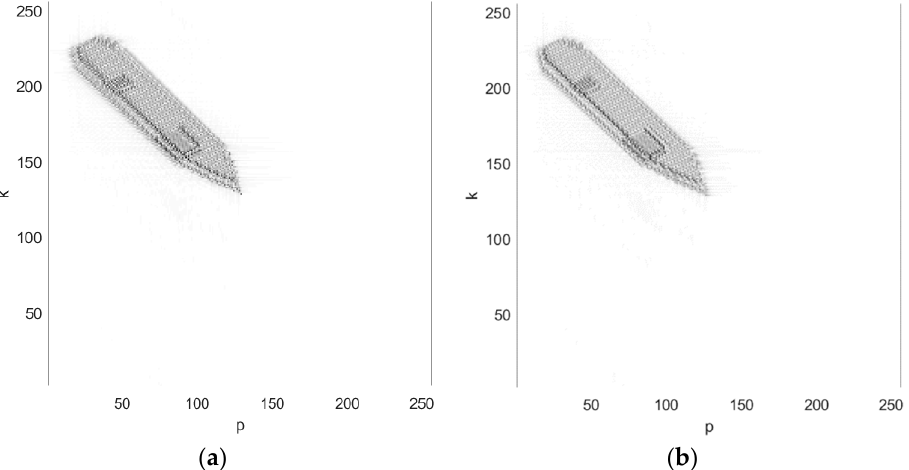
Figure 7. The SAR image of the ship target before ( a ) and after ( b ) application of the higher-order phase correction, depicted by normalized intensities of the scattering points.